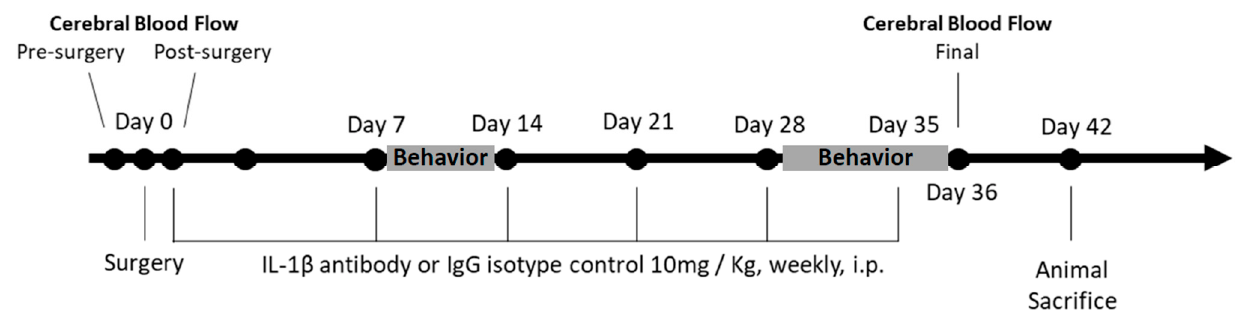
Figure 1. Schematic of the experimental design for the assessment of the effects of hypoperfusion and an IL-1 β antibody on behavior and neuropathology in mice.